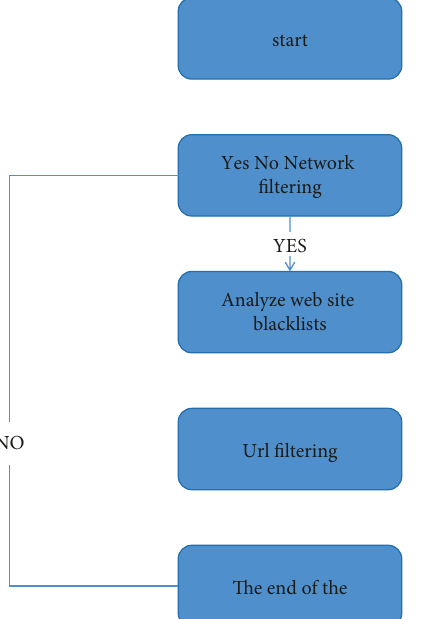
Figure 4: Process flow of URL black-and-white list